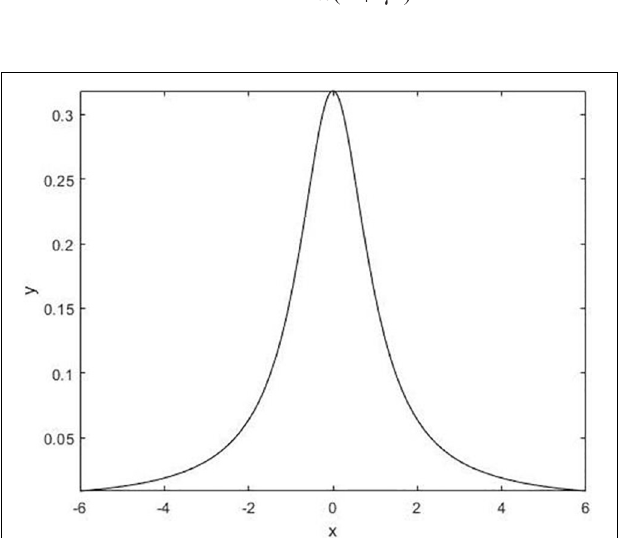
FIGURE 2 | Standard Cauchy distribution density